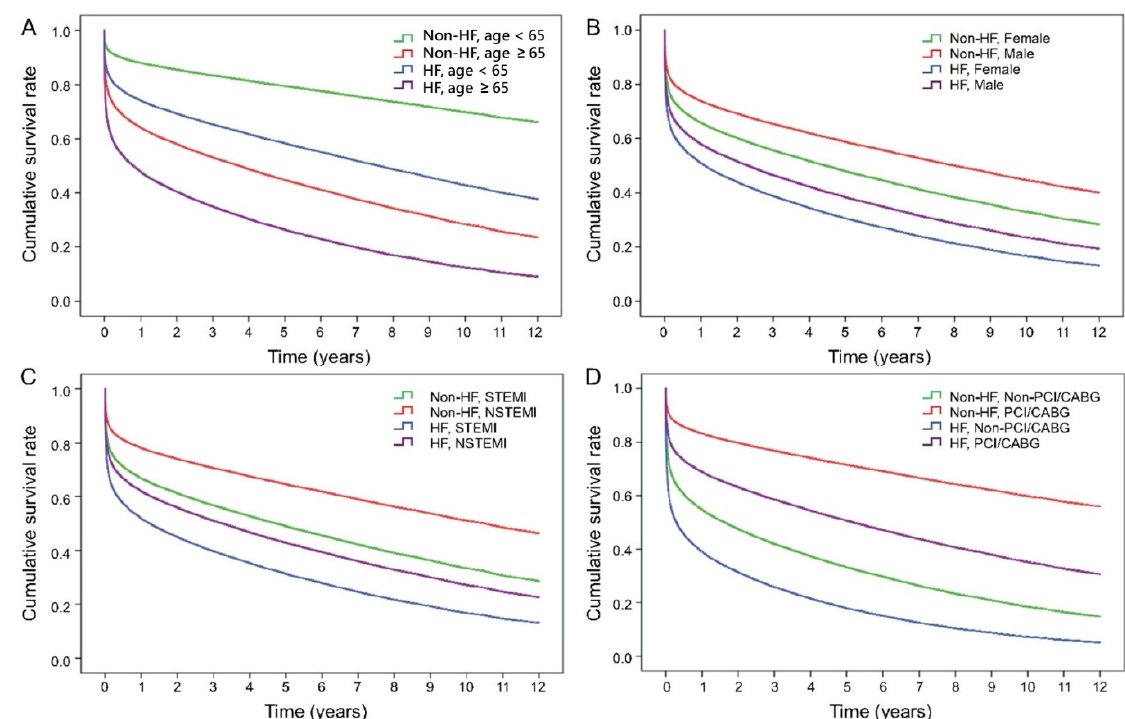
Figure 3. Subgroup analysis of survival curves for first ever AMI patients with or without HF in groups of different characteristics. ( A ) Age ≥ 65 and <65 years-old; ( B ) gender; ( C ) STEMI and NSTEMI; ( D ) receiving reperfusion intervention (PCI/CABG) or none.